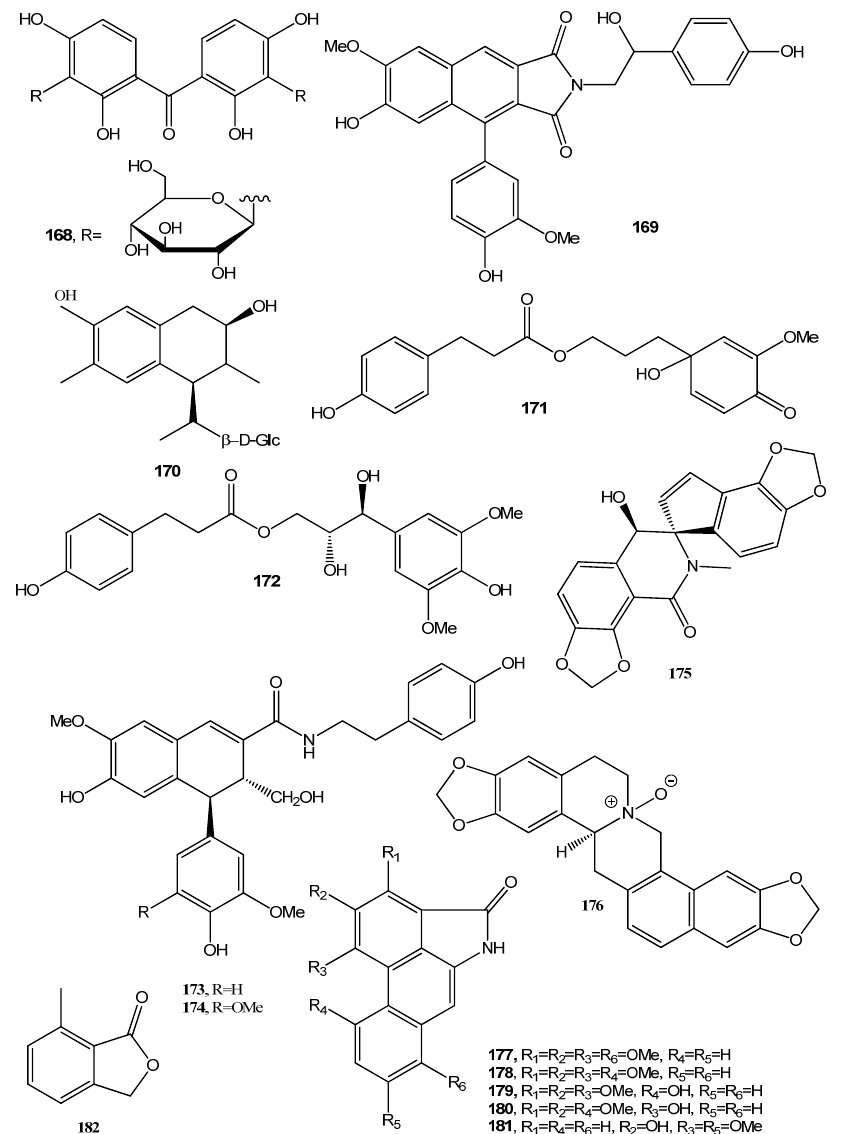
Figure 12. The structures of compounds 168 – 182 . NTFT and NTCT were isolated together with an isoindole alkaloid, named oleraisoin- dole ( 169 , Figure 12), together with four known compounds, from Portulaca oleracea L. (Portulacaceae) [135]. The known compounds were identified as 7 (cid:48) -ethoxy- trans -feruloylty- ramine, N - trans -feruloyl-3-methoxytyramine, aurantiamide and ferulic acid methyl ester. Oleraisoindole ( 169 ) inhibited NO production in RAW 264.7 cells induced by LPS [135]. NTCT and cadinane sesquiterpenoid glucoside, characterized as 2 β ,7,3-trihydroxycala- menene 3- O - β - D -glucoside ( 170 , Figure 12) were isolated together with five known com- pounds from the stem bark of Abelmoschus sagittifolius (Malvaceae) [136]. This plant is con- sidered an edible food in Hainan Island of China and southeast Asian countries and widely used in folk medicine for the treatment of phthisis, cough, constipation, neurasthenia, carbuncle sore swollen poison, dizziness and lumbocrural and stomach pains. The already known compounds were identified as N -( p - trans -coumaroyl)- N -methyltyramine, cleomis- cosin A, 9,12,13-trihydroxy-10,15-heptadecadienoic acid, cytochalasin B and marmesinin. All the isolated metabolites showed moderate cytotoxicity against Hela and HepG-2 human cancer cell lines erythro-guaiacylglycerol,